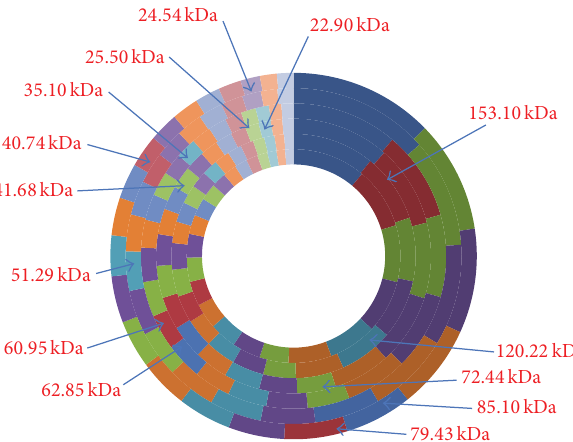
Figure 2: SDS-PAGE protein profiles have been depicted cen- tripetallyfrom M.agalactiae (RPNS216)WCA; M.agalactiae (RPNS 216) SSA; M. agalactiae (RPNS 210) WCA; M. agalactiae (RPNS 210) SSA; M. bovis (NC 317) WCA; M. bovis (NC 317) SSA.